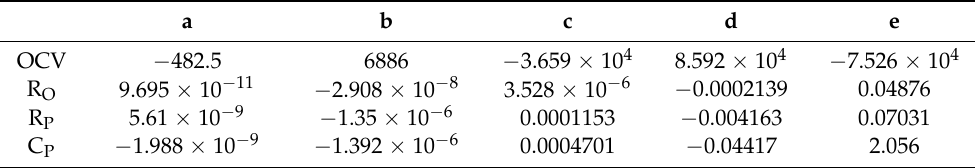
Table 3. The obtained curve fitting